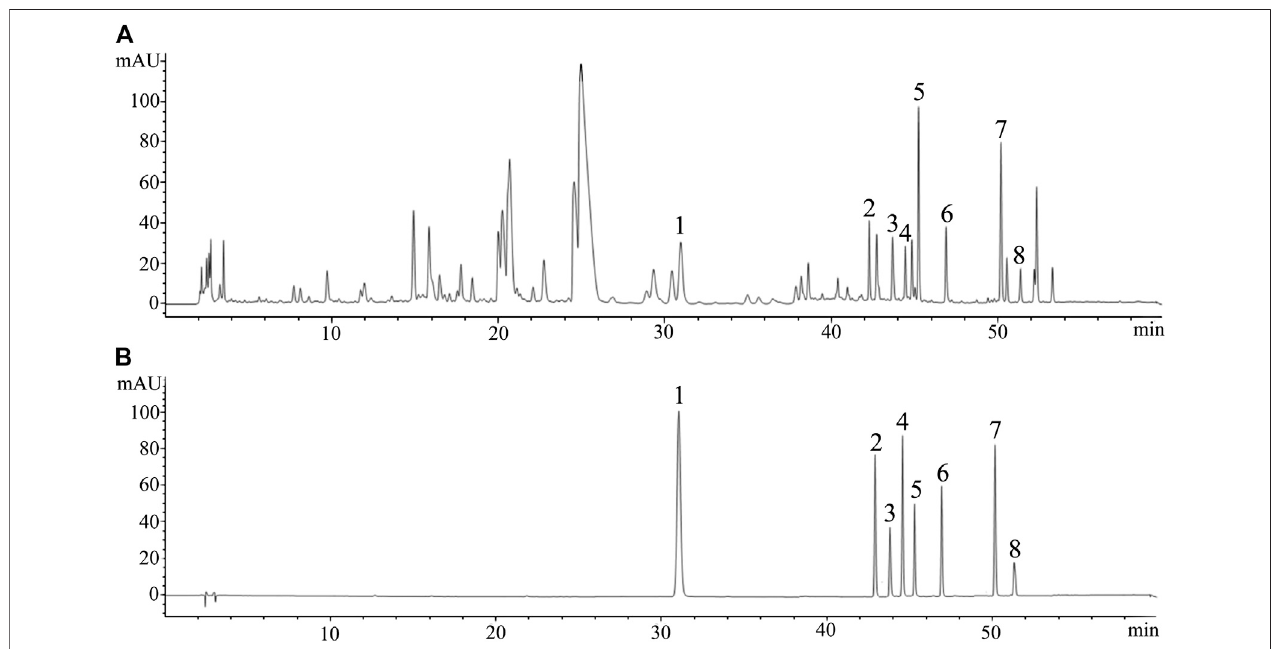
FIGURE3| The fi ngerprintofGDDandmixtureof8standardproducts. (A) the fi ngerprintofGDD. (B) mixtureof8standardproducts.1)quercetin;2)aloe-emodin; 3) rhein; 4) kaempferide; 5) curcumin; 6) emodin; 7) chrysophanol; 8) physcion.